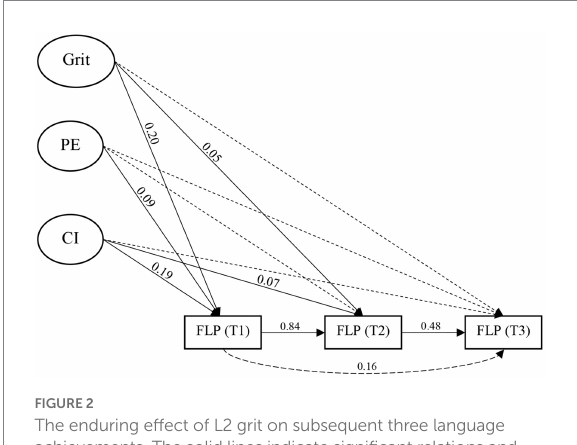
FIGURE 2 The enduring effect of L2 grit on subsequent three language achievements. The solid lines indicate significant relations and the dotted lines